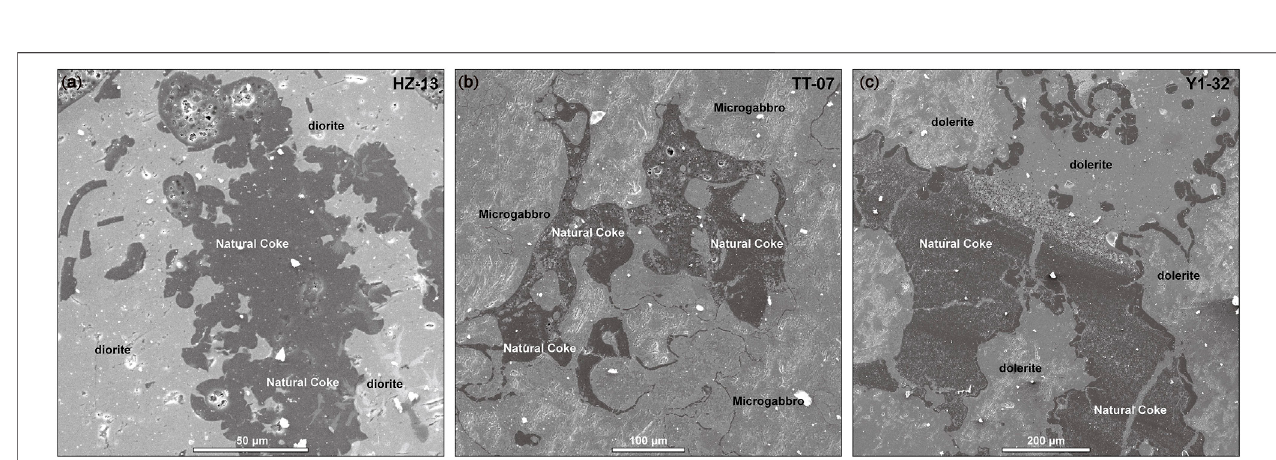
FIGURE 3 | SEM image of plutonic rock samples, showing partially-assimilated porous natural coke inclusions with rounded corroded margin: (A) HZ-13; (B) TT- 07; (C) Y1-32.